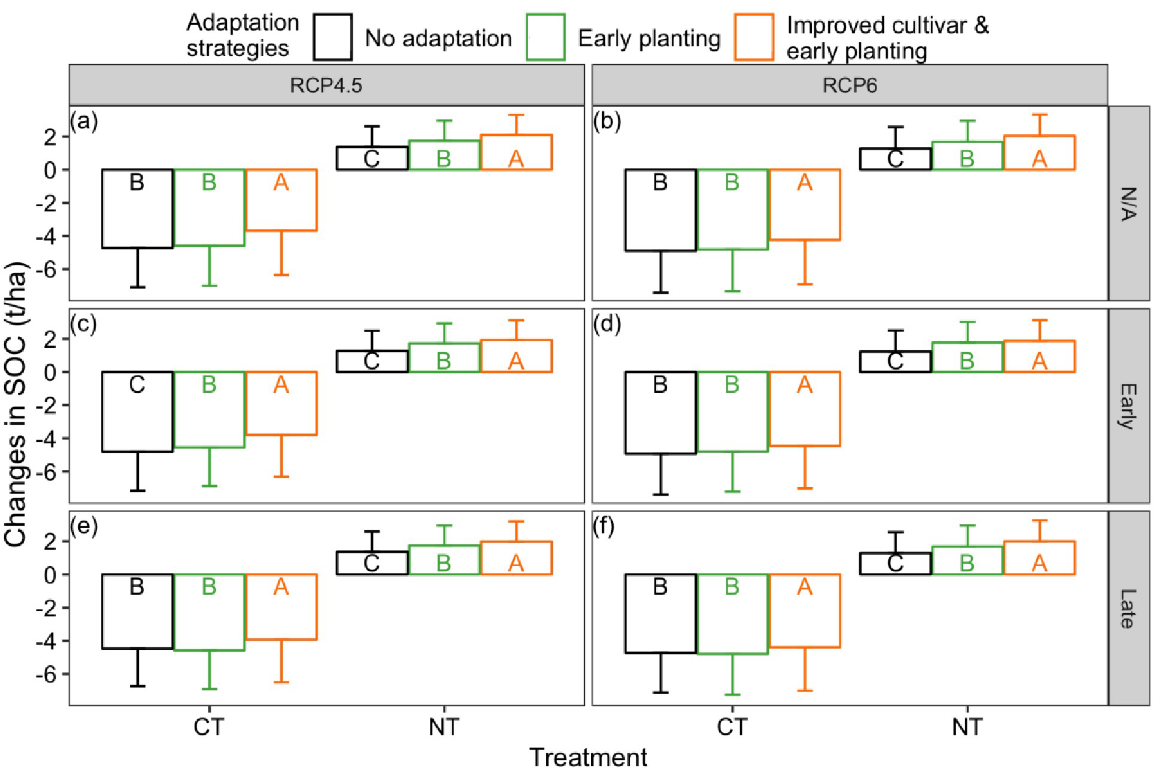
Fig 9. Average and standard deviation of the SOC with and without climate adaptation strategies under conventional tillage (CT) and no- till (NT) in the 28 years for various scenarios: (a-b) RCP4.5 and RCP6 climate without changing precipitation frequency, (c-d) RCP4.5 and RCP6 climates combined with changing precipitation frequency at maize and wheat early growth stage, (e-f) RCP4.5 and RCP6 climate combined with changing precipitation frequency at maize and wheat late growth stage (error bars represent the standard deviation; adaptation strategies sharing the same letter are not significantly different at P = 0.05 using Tukey’s honestly significant difference test within the tillage